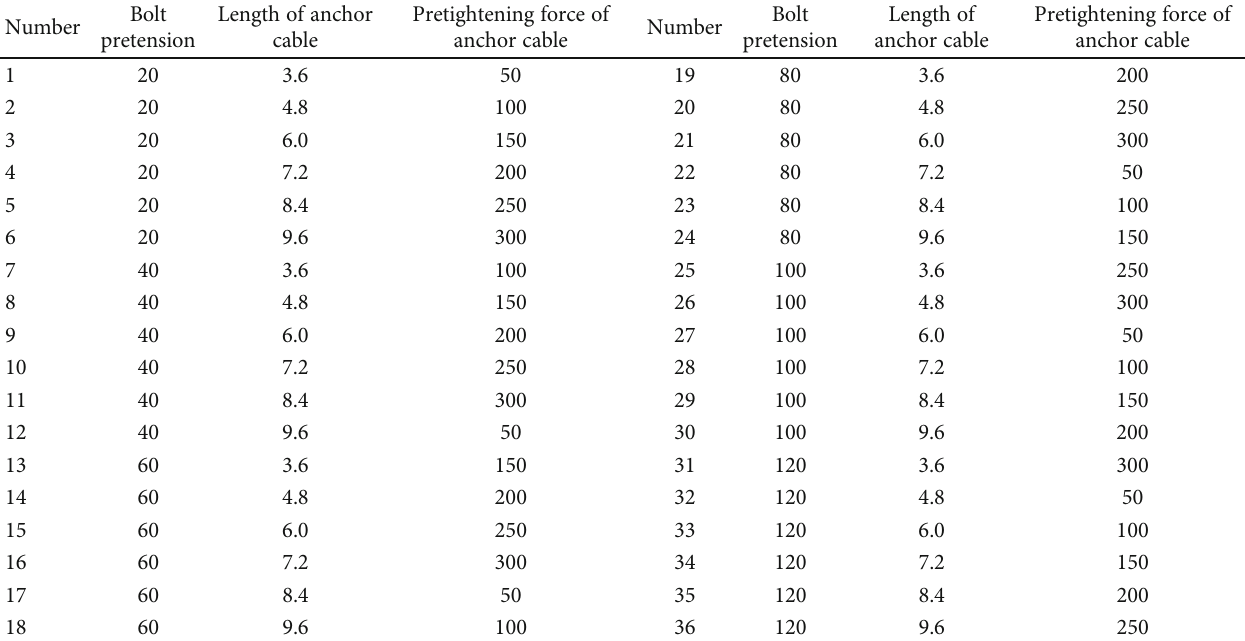
Table 5: Orthogonal programming